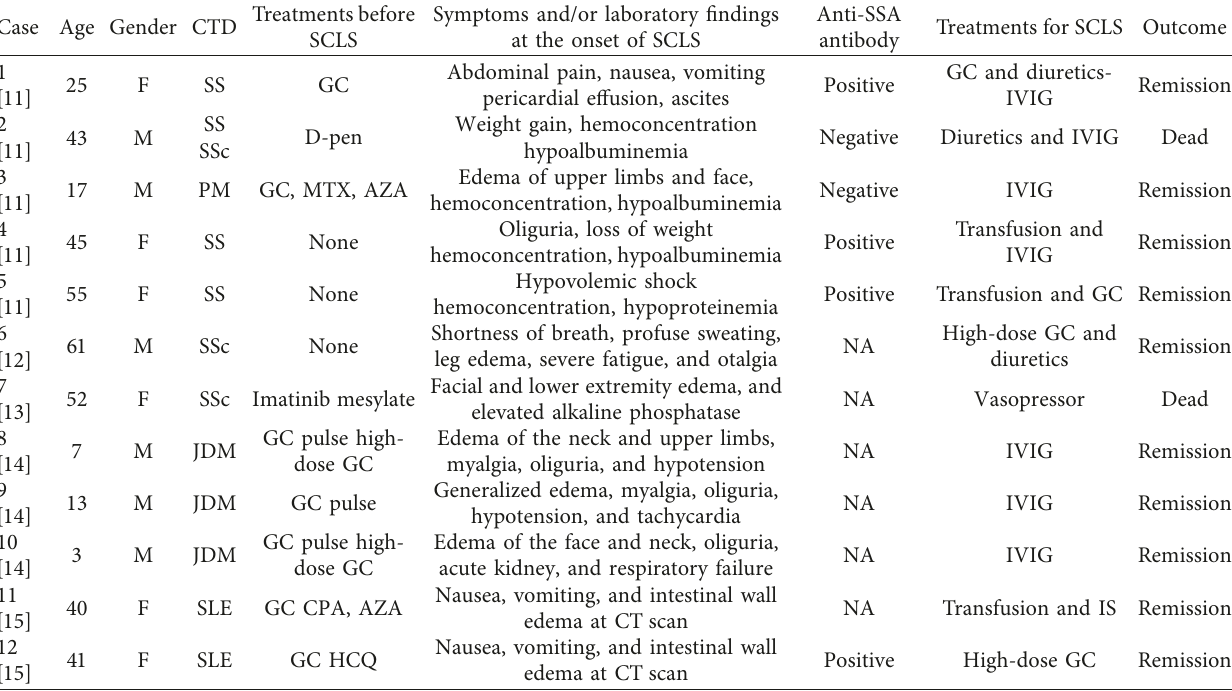
Case Age Gender CTD